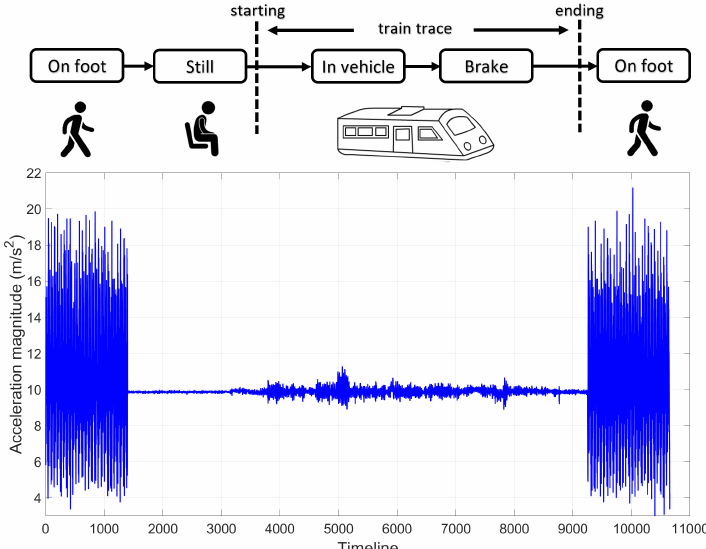
Figure 8. The activity recognition process to determine the starting and ending points of a train